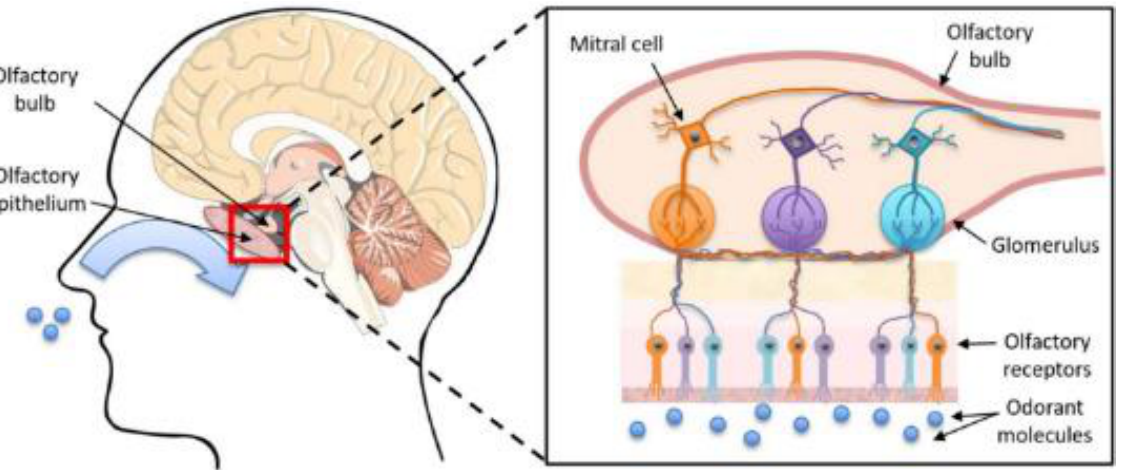
Figure 1. Schematic of the human olfactory system. Reprinted with permission from Ref. [11]. Copyright 2018, MDPI.